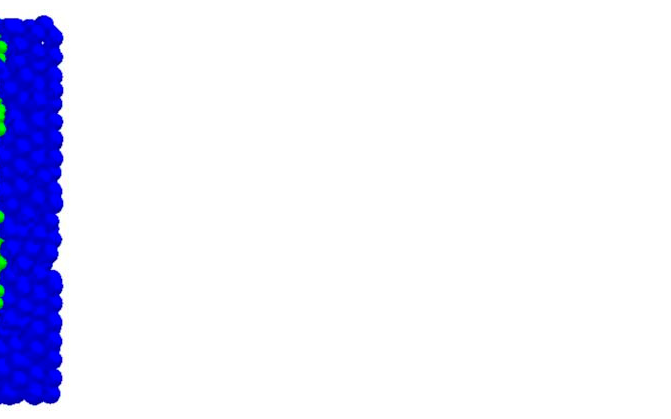
Table 1. Parameters of the particle